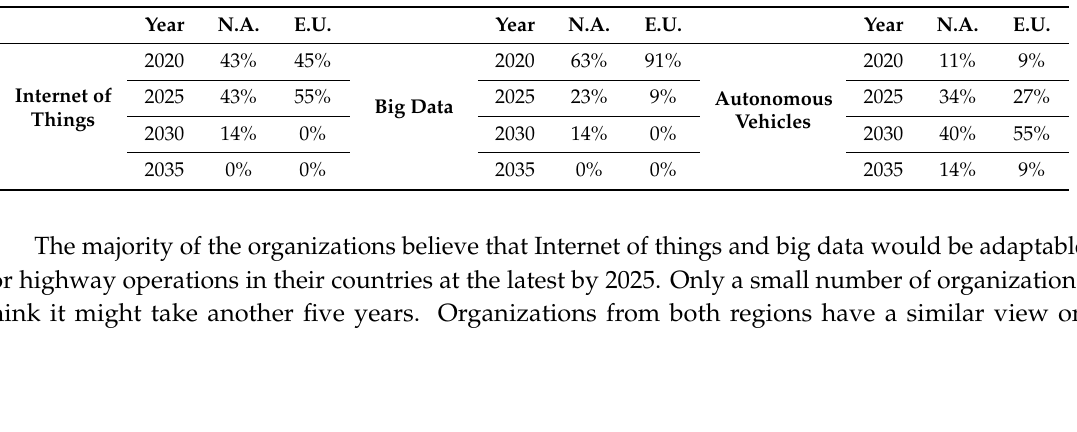
Table 3. Innovative technologies maturity time-line North America v/s European Union.